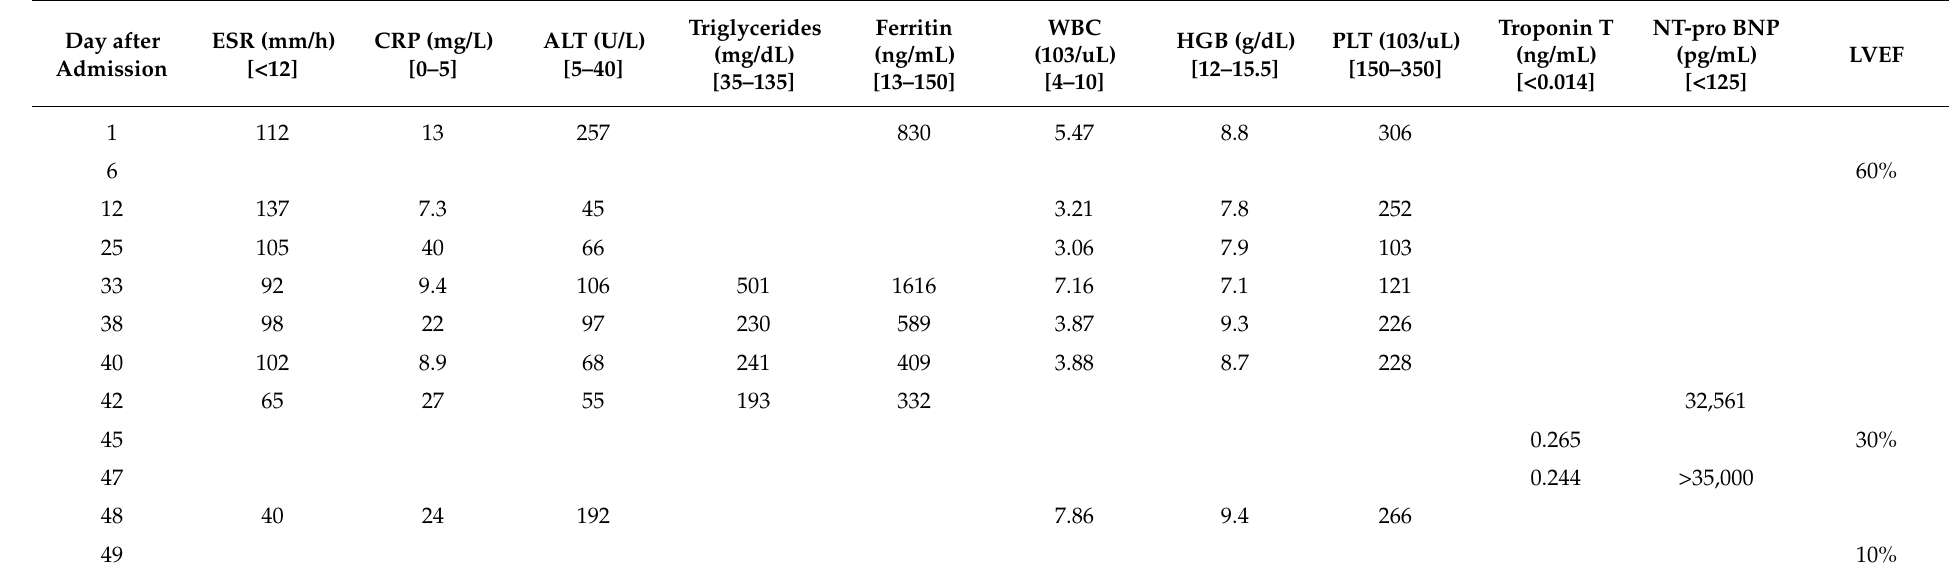
Table 1. Laboratory and echocardiographic findings in the course of